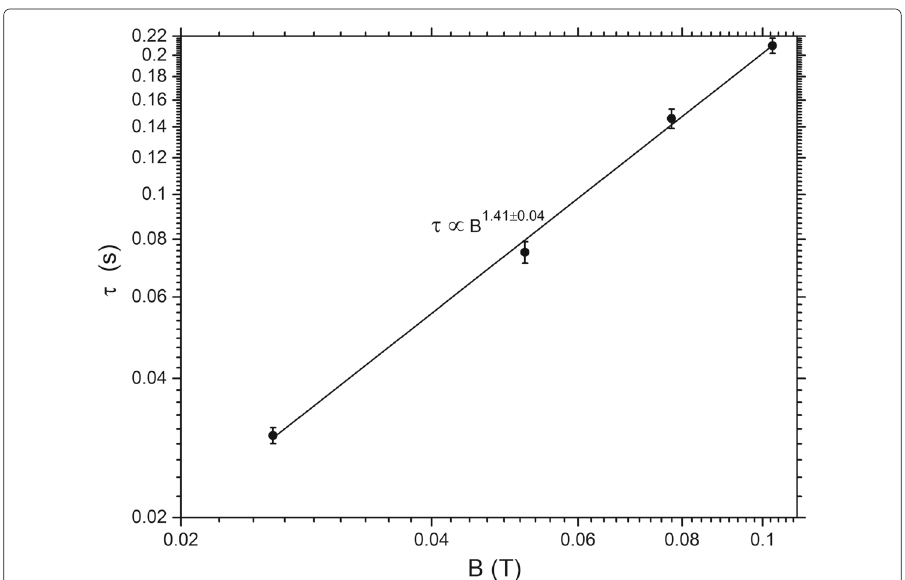
Fig. 8 Confinement time dependence on magnetic field showing τ ∝ B 1.41 ±